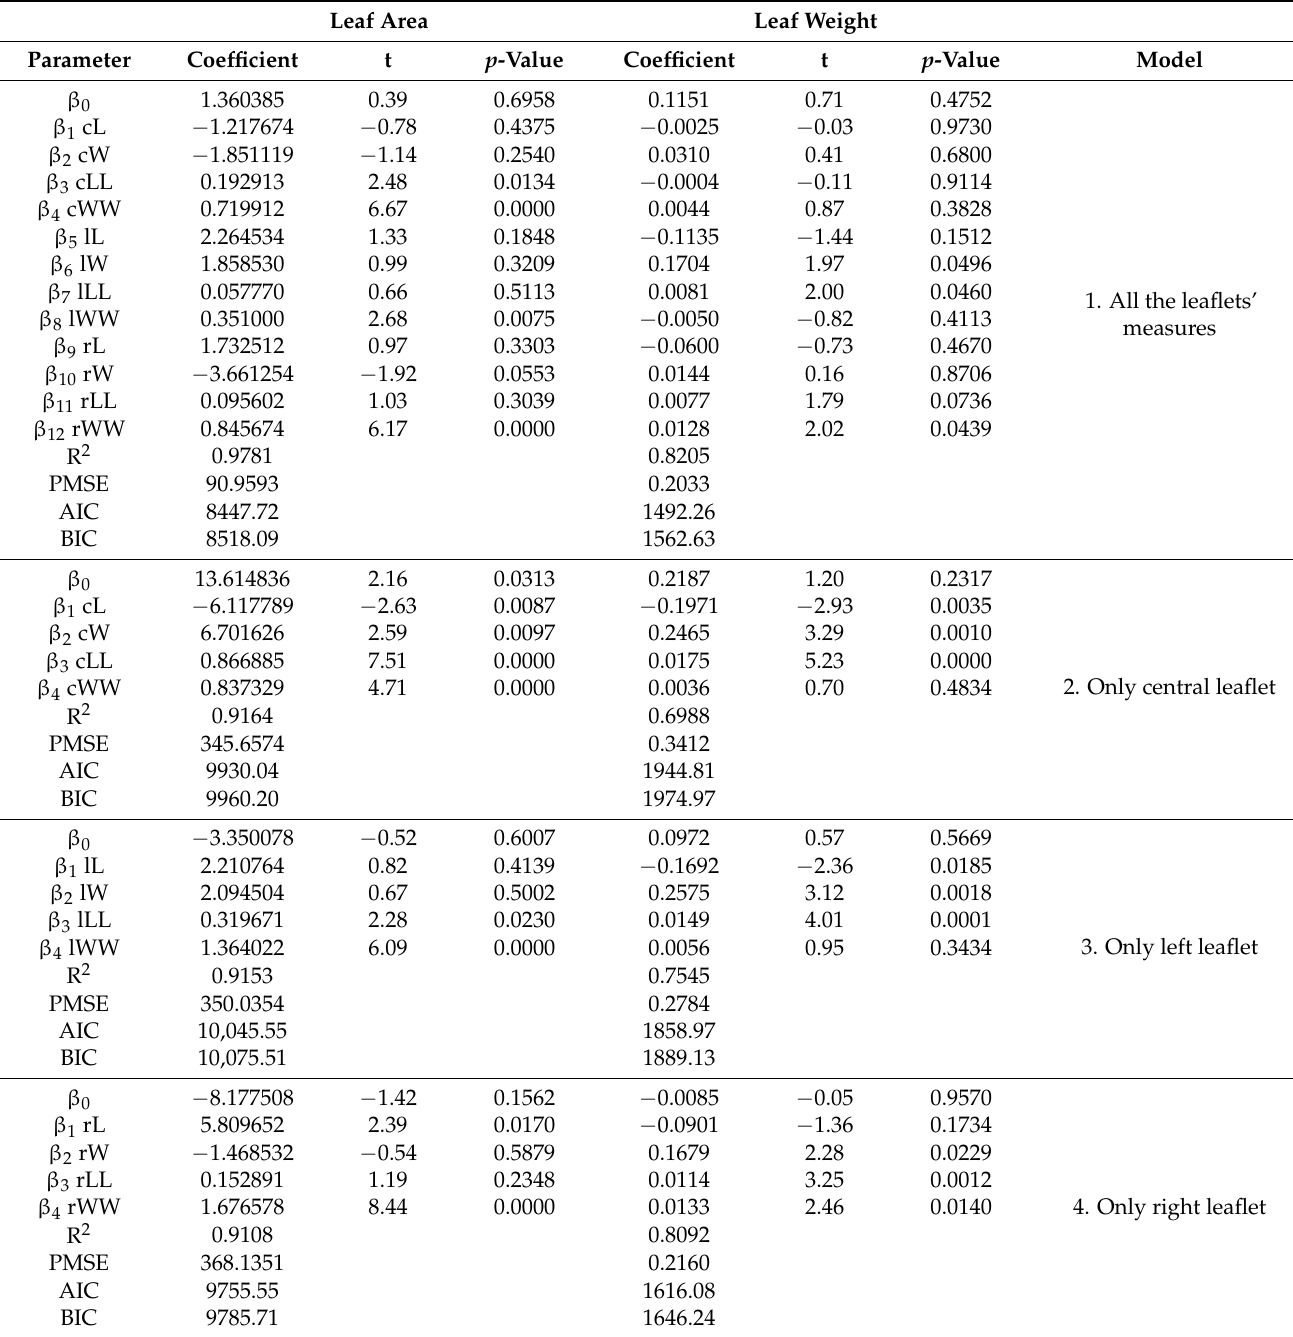
Table 2. Regression coefficients of the five models evaluated to predict leaf area and weight from leaflet measures of improved lines of common bean. Prediction mean square error (PMSE) and determination coefficient (adjusted R 2 ) are calculated on the validation